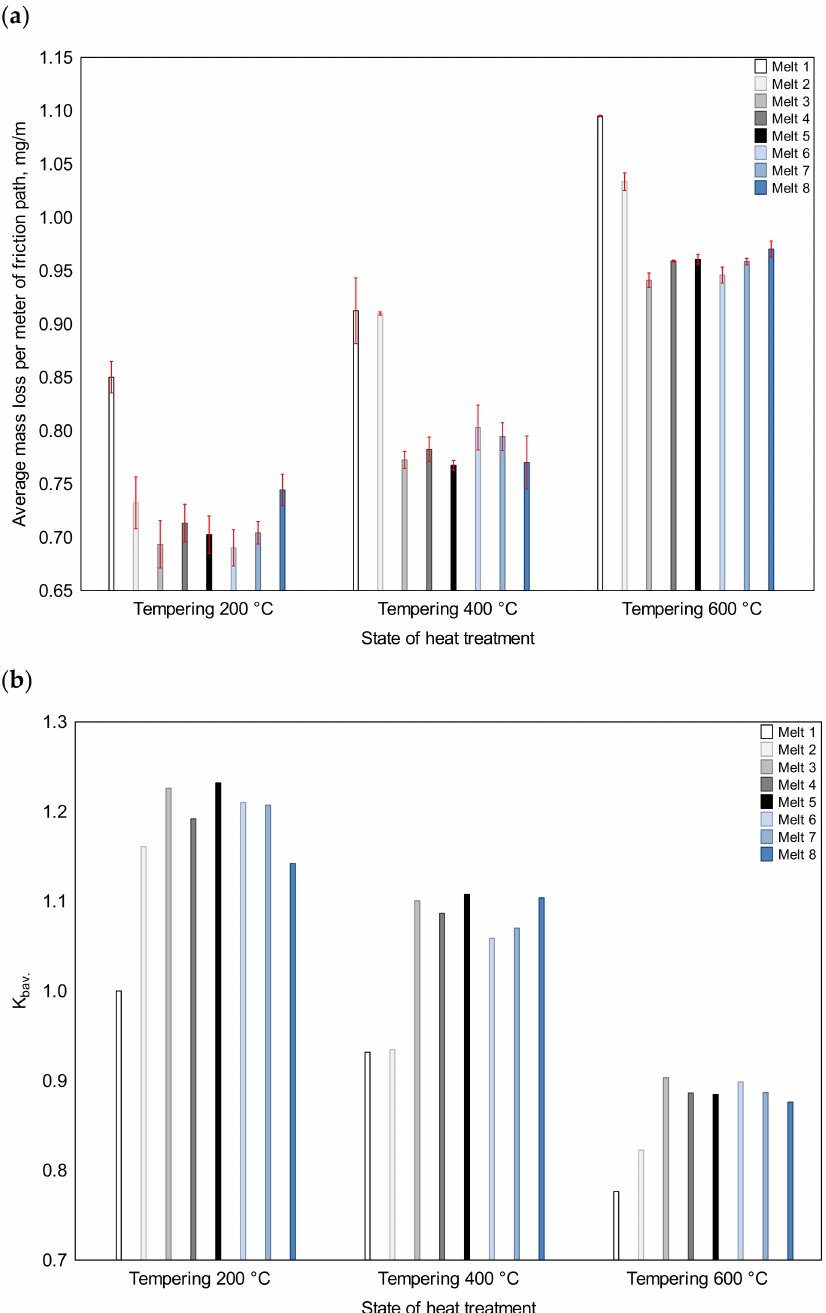
Figure 13. Values of the average mass loss per meter of friction path ( a ) and the wear resistance index ( b ) of the analyzed cast steels after quenching and tempering at 200, 400 and 600 ◦